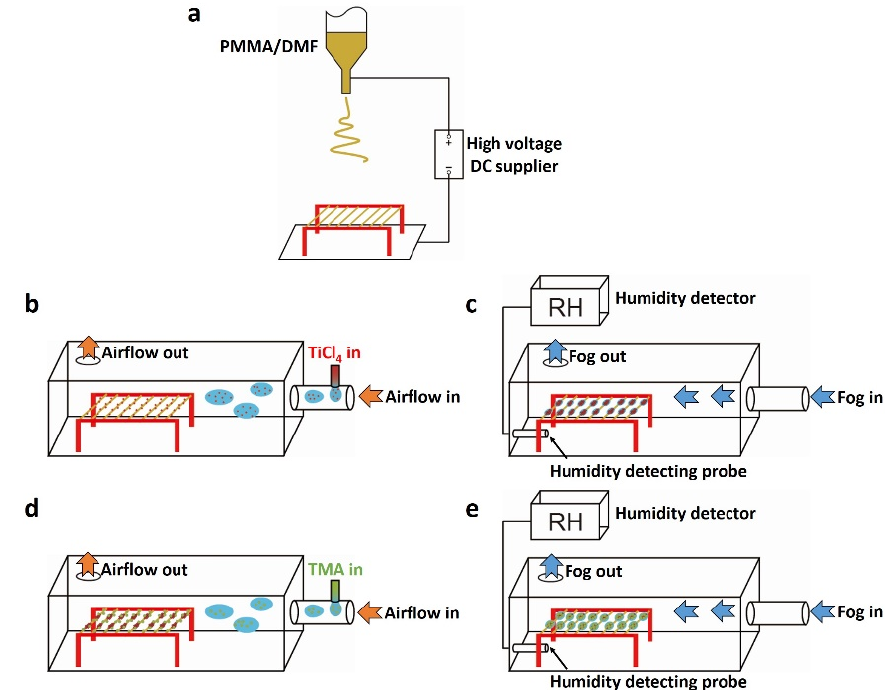
Figure 1. Illustrations of fabrication process of multi-scale heterogeneous hump-on-string fibers (MHHFs). ( a ) Electrospinning process; ( b ) nanoparticles containing Ti (NPCTi) absorption; ( c ) The first wet-assembly process; ( d ) nanoparticles containing Al (NPCAl) absorption; ( e ) The second wet-assembly process.